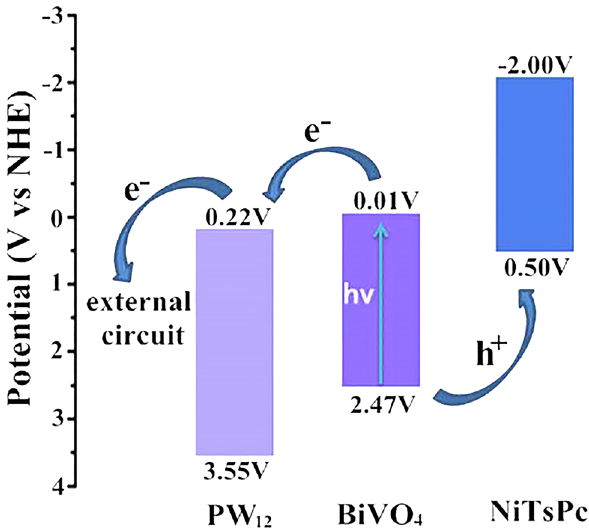
Figure 18: A schematic illustration showing charge transfer processes between BiVO 4 /PW 12 /NiTsPc. Adopted with permission from ref.